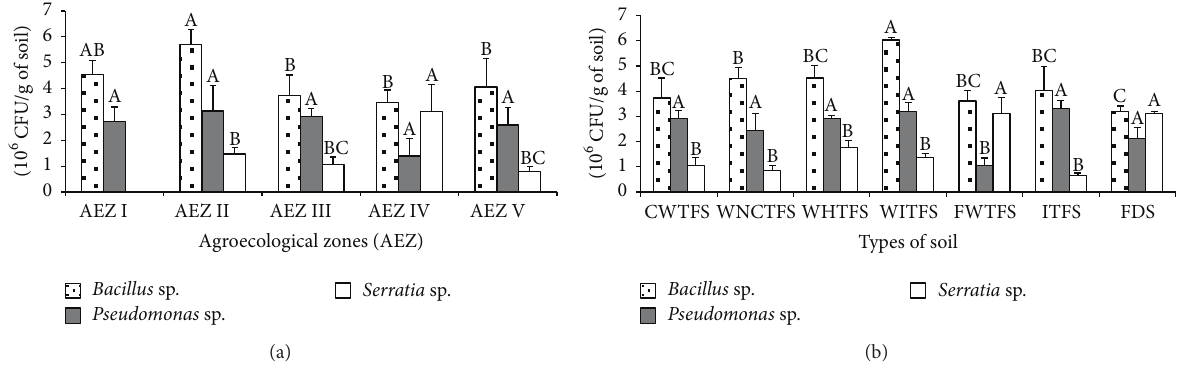
Figure 3: Distribution of rhizobacteria density according to (a) AEZ and (b) type of soil. WCTFS: Washing and Concretion Tropical Ferruginous Soil; WNCTFS: Washing and No Concretion Tropical Ferruginous Soil; WHTFS: Washing and Hydromorphic Tropical Ferruginous Soil; WITFS: Washing and Idurate Tropical Ferruginous Soil; FWTFS: Few Washing Tropical Ferruginous Soil; ITFS: Impoverished Tropical Ferruginous Soil; FDS: Few Developed Soil. The means with different letters are significantly different with probability level of 5% according to Student-Newman-Keuls